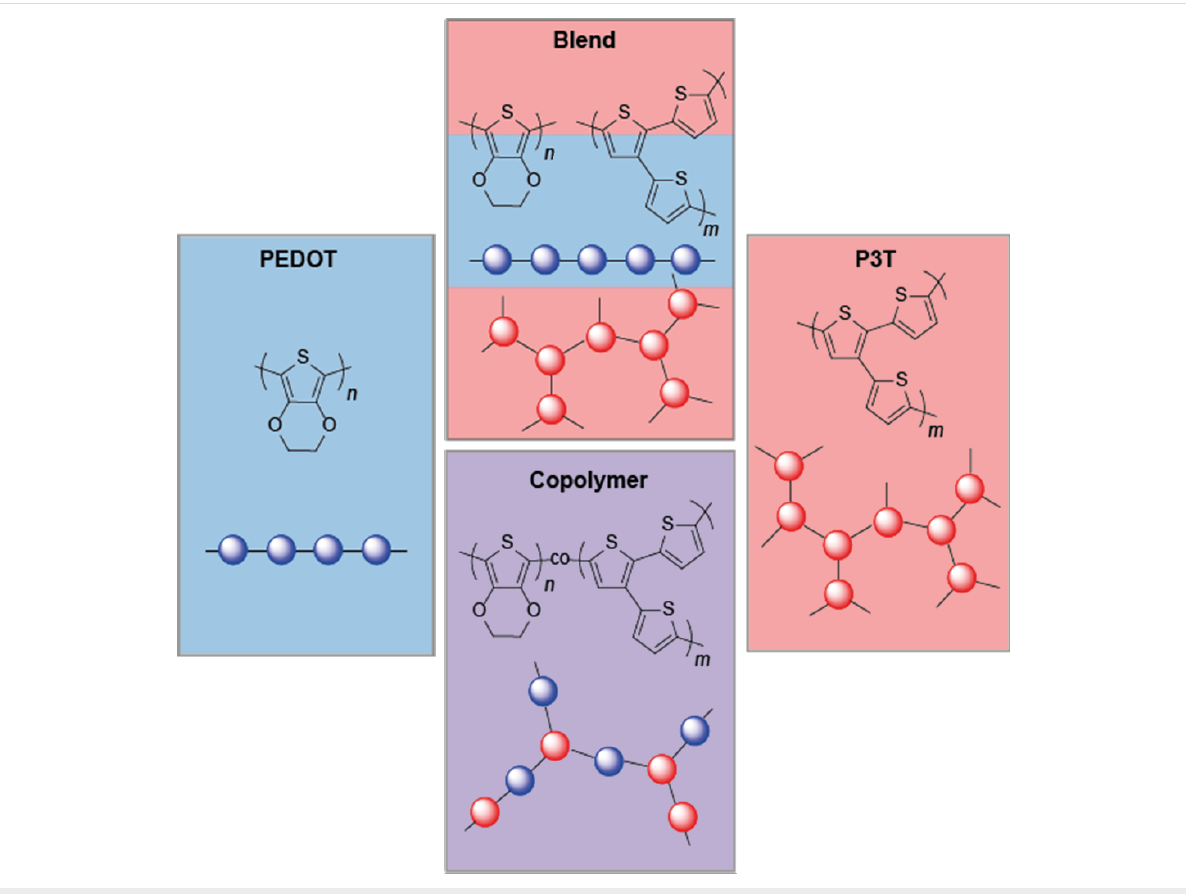
Scheme 1: Polymer constitutions of the electropolymerized